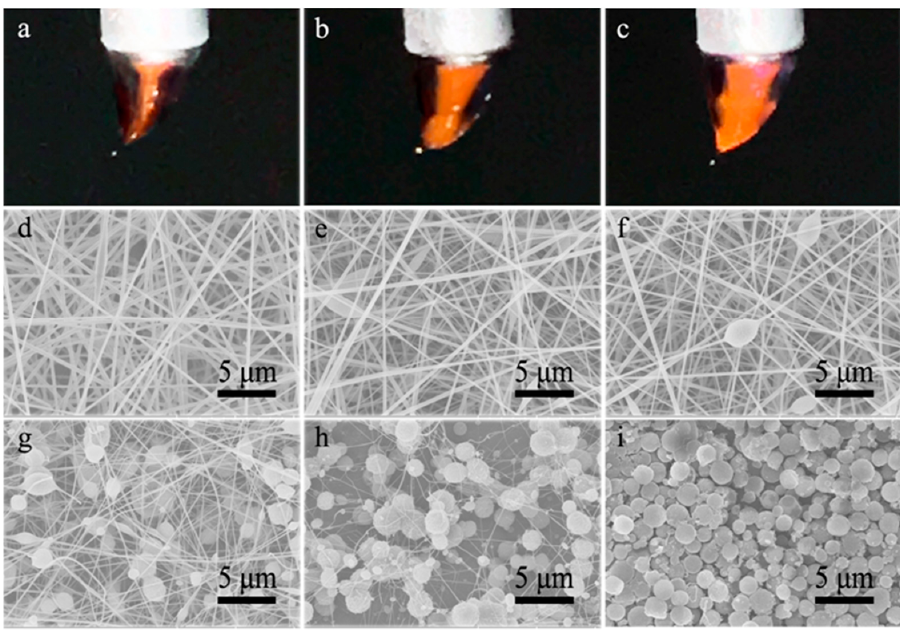
Figure 3. ( a – c ) Images of compound Taylor cones formed in the co-electrospinning of core CA-D solution and shell CA-AD21 solution under the core-to-shell flow ratio of ( a ) 1:6, ( b ) 1:1.5 and ( c ) 1:1, respectively; ( d – i ) SEM images of resultant nanofibers prepared under core-to-shell flow ratio of ( d ) 1:6, ( e ) 1:4.5, ( f ) 1:3, ( g ) 1:1.5, ( h ) 1:1 and ( i ) 1:0.2, respectively.